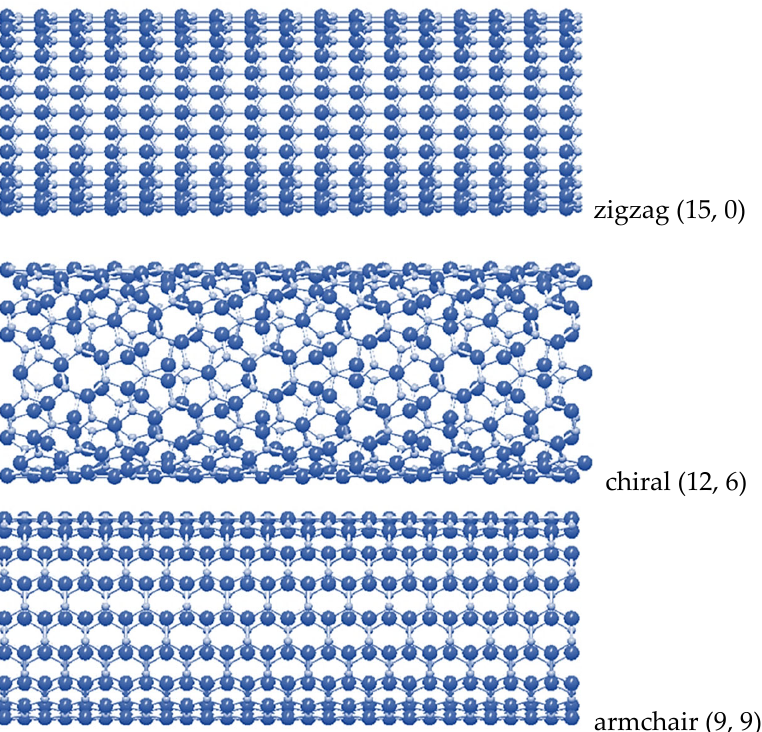
Figure 2. Configurations (15, 0) zigzag, (12, 6) chiral and (6, 6) armchair SWInNNTs, obtained using the software Nanotube Modeler . In atoms are shown in bright blue; N atoms in pale blue.